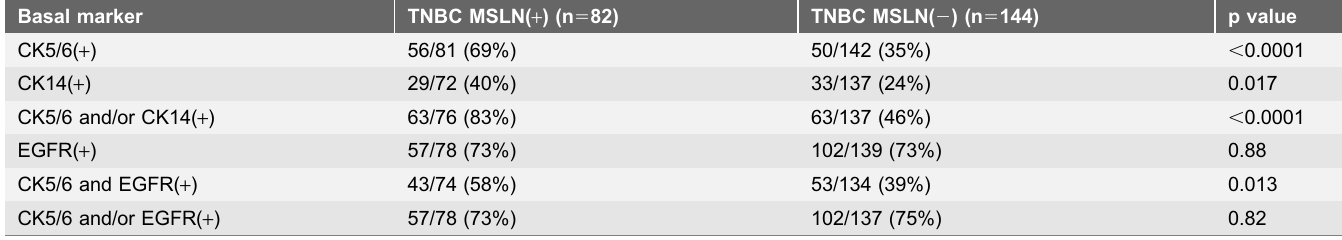
Table 5. MSLN and basal markers expression in